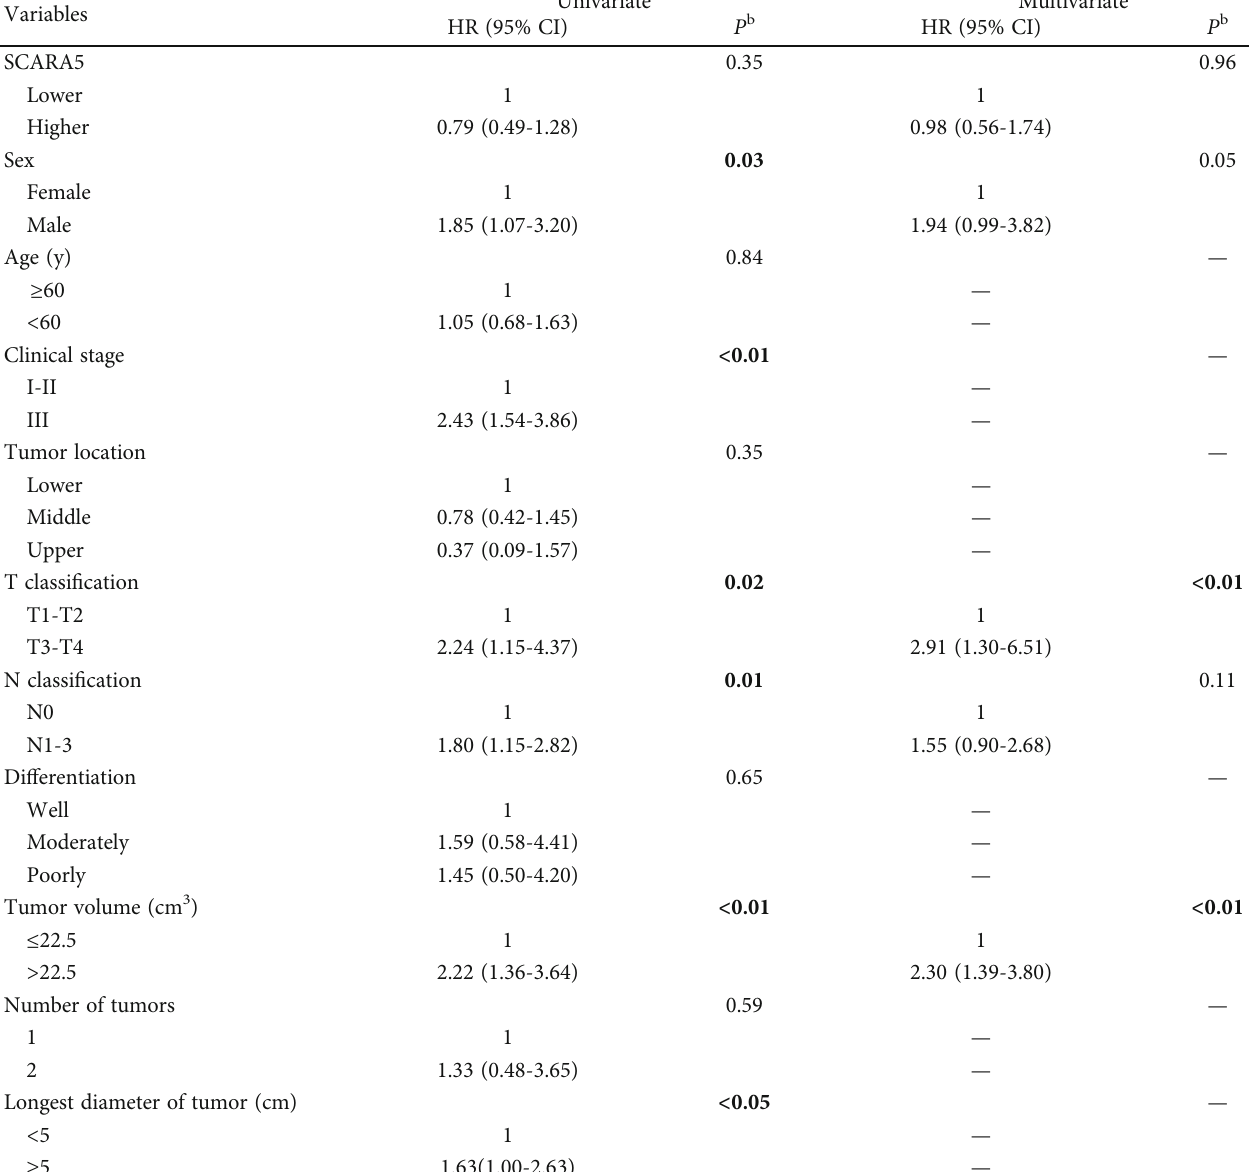
Table 5: Univariate and multivariate Cox analysis of esophageal carcinoma speci fi c